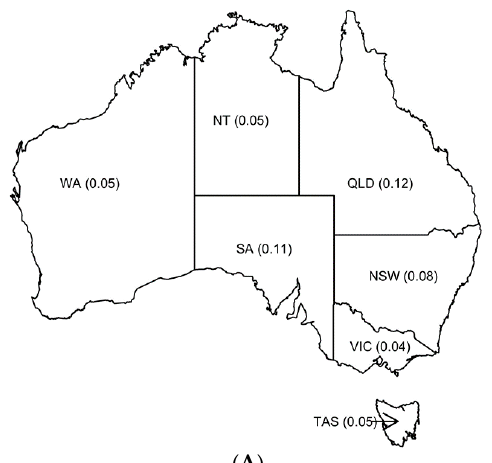
Figure 3. Proportions of total ads for relinquished cats on Gumtree and PetRescue from 9 to 26 February 2016, and Royal Society for the Prevention of Cruelty to Animals (RSPCA) shelter admissions for each Australian State/Territory. States/Territories are ordered in increasing proportion of total population. The square symbol is the proportion of the Australian population for each State/Territory (Note: The proportion of the Australian population in each State/Territory is: NSW 31.7%, Vic 24.9%, Qld 19.9%, WA 10.8%, SA 7%, Tas 2.1%, ACT 1.6% and NT 1%). The per capita values for each marketplace and State/Territory are shown in Figure 4. The per capita number of Gumtree ads are highest for the Northern Territory and lowest in Victoria, while PetRescue and RSPCA figures per capita are highest in Queensland. Per capita rates for the RSPCA are higher than for Gumtree and PetRescue. The ACT per capita figures for Gumtree, PetRescue and the RSPCA are 0.08, 0.12 and 6.3 per 1000 residents, respectively. The per capita rate of cat admissions to RSPCA shelters is higher in the ACT than any other State/Territory.